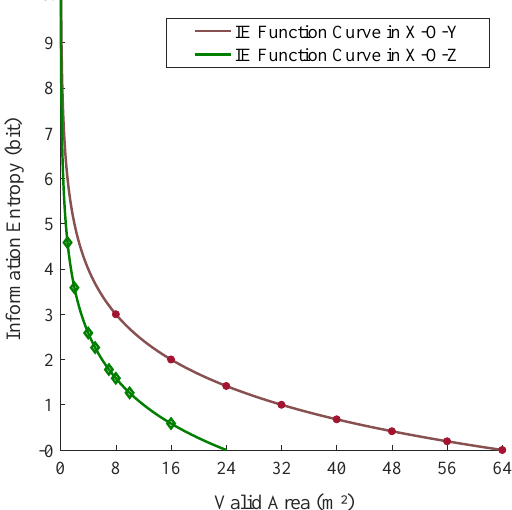
Figure 8. The relationship between the valid area (VA) and the information entropy (IE) for the link in the X-O-Y and X-O-Z planes,